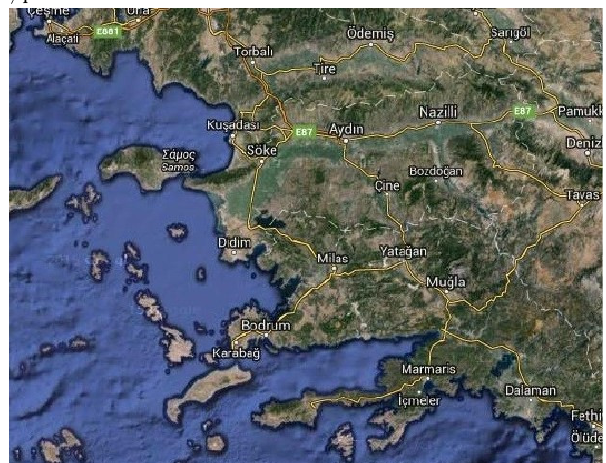
Fig. 1. Location of the Aydın region. Map data: US Dept